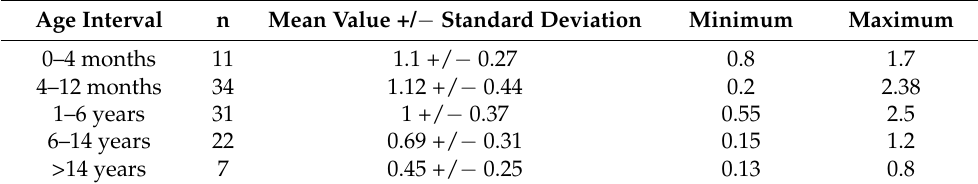
Table A2. Daily protein intake via amino acid mixture (g/kg body weight).